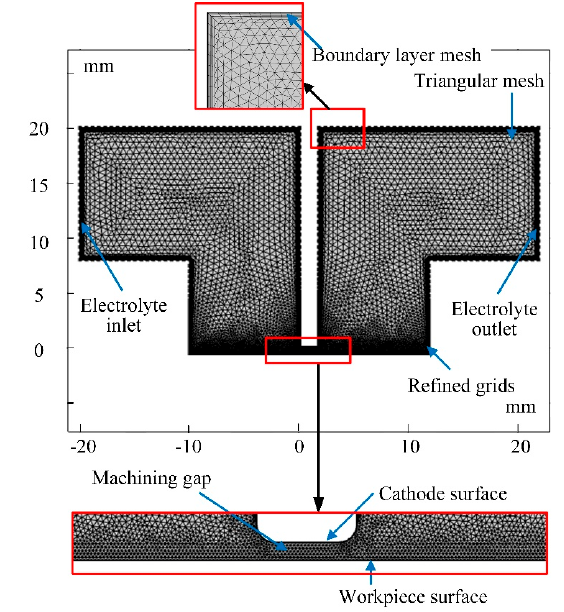
Figure 4. Mesh generation of the model.